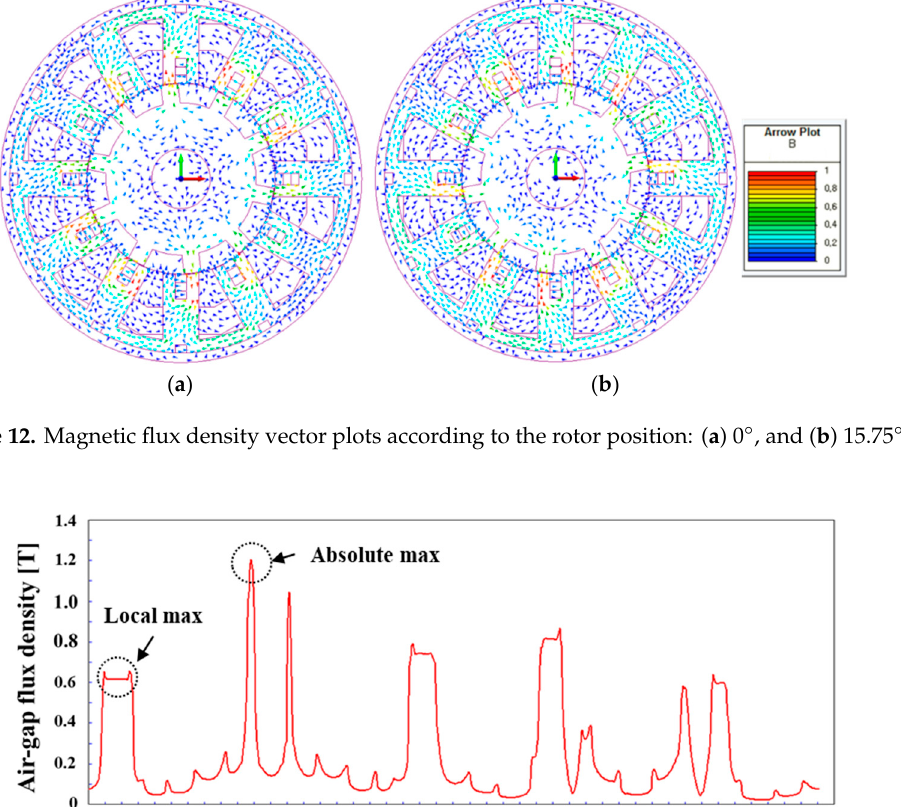
Figure 11. Current charging characteristics of the NI HTS field coil installed in the designed FSM. Appl. Sci. 2020 , 10 , x FOR PEER REVIEW